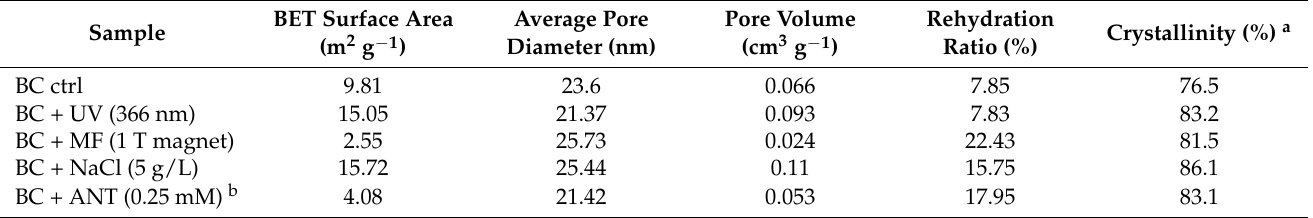
Table 3. BET analysis, rehydration ratio, and crystallinity of the BC synthesized under the different physical and chemical